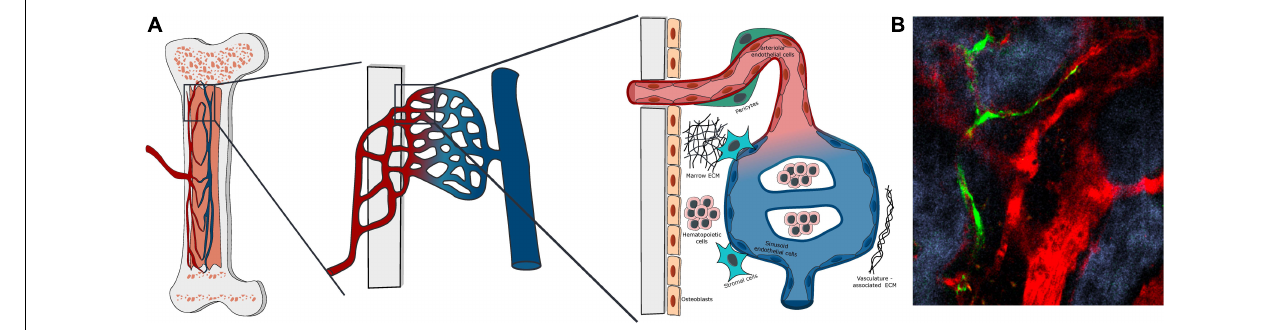
FIGURE 1 | Bone marrow vascular structure. (A) Scheme of the organization of BM vasculature at different magnifications. The BM vasculature is highly interconnected with the tissue matrix, with small arterioles covered by pericytes entering the marrow from the bone and merging with the venous system via a network of sinusoidal capillaries. The vascularized marrow space is populated by hematopoietic and stromal cells embedded in a unique extracellular matrix. (B) Representative Z-stack two-photon microscopy image of vascular organization in the mouse calvarial bone marrow, with Nestin-GFP peri-arteriolar pericytes (green), TRITC-dextran labeled vascular lumen (red) and second harmonic generation (SHG) bone matrix (blue).